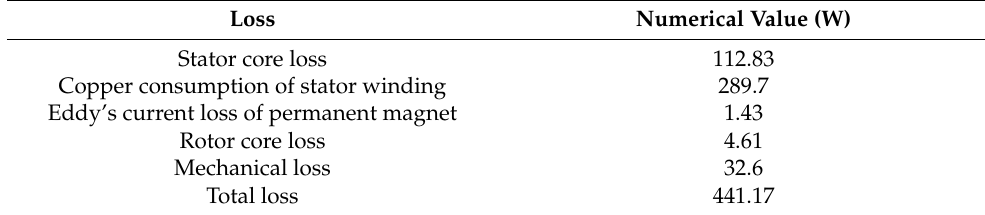
Table 2. Loss of permanent magnet synchronous